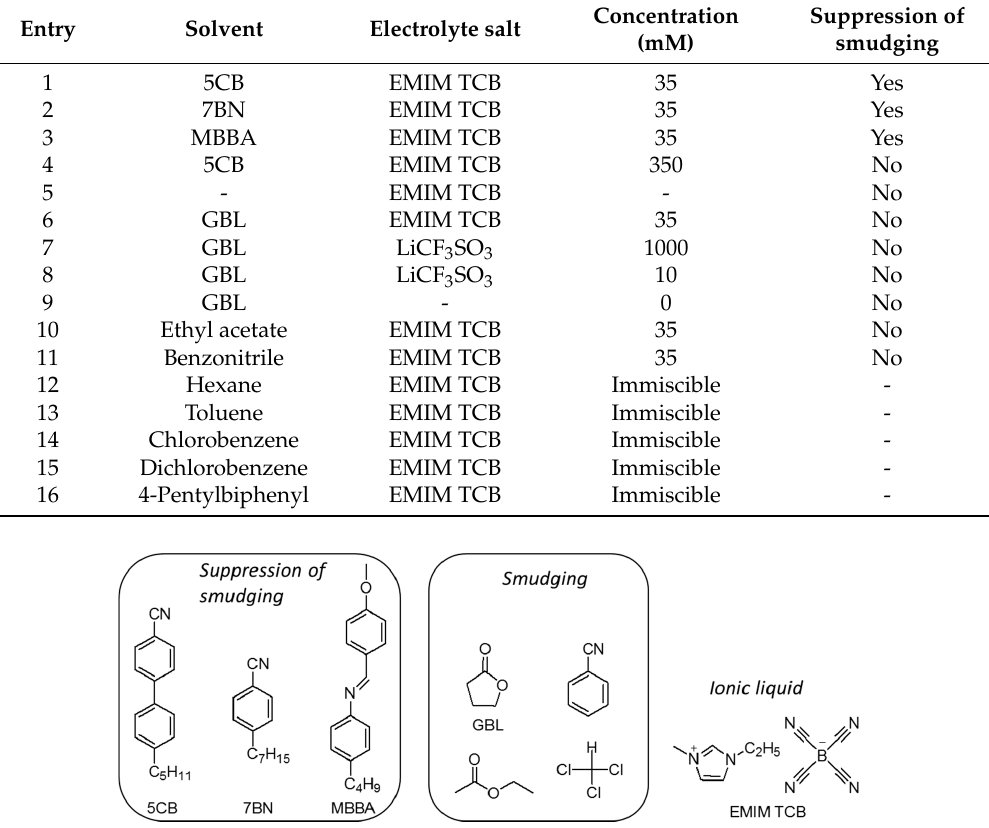
Scheme 3. Chemical structures of organic solvent used for smudging test.